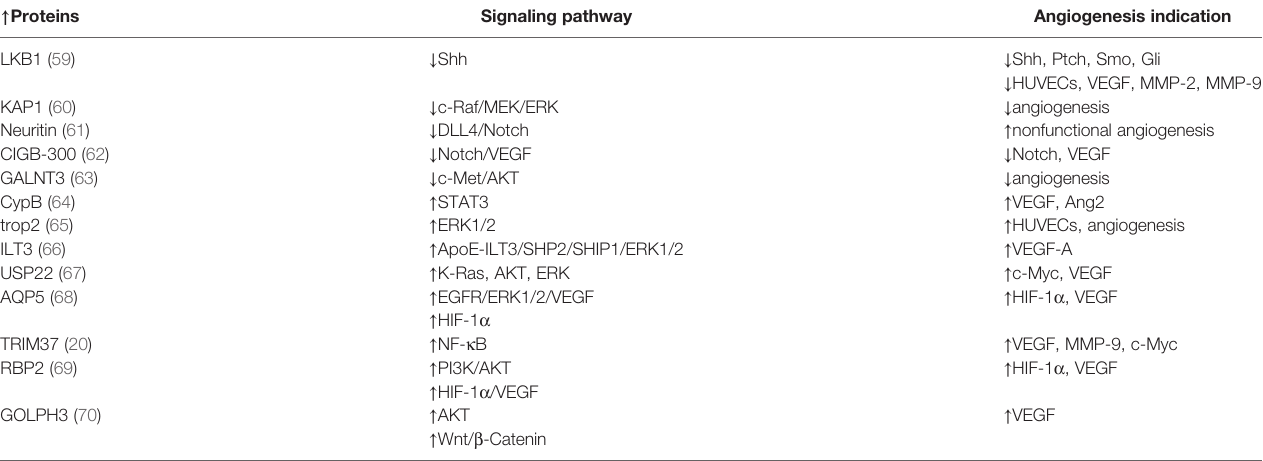
TABLE 3 | Research progress of proteins in angiogenesis in lung cancer. ↑ Proteins